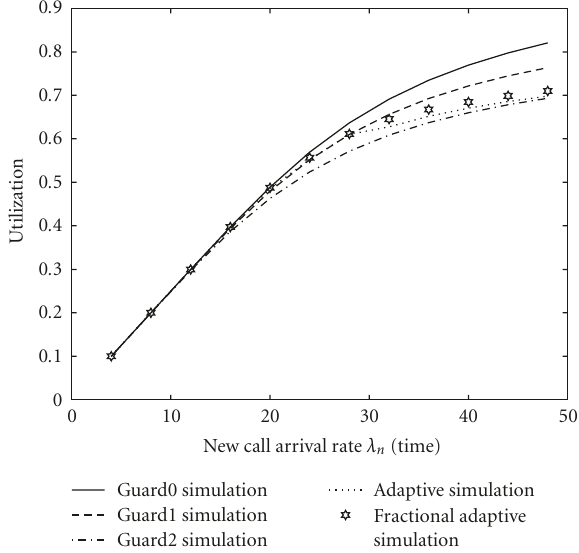
Figure 5: Analytical and simulation results of new call blocking probability for the two-cell system.